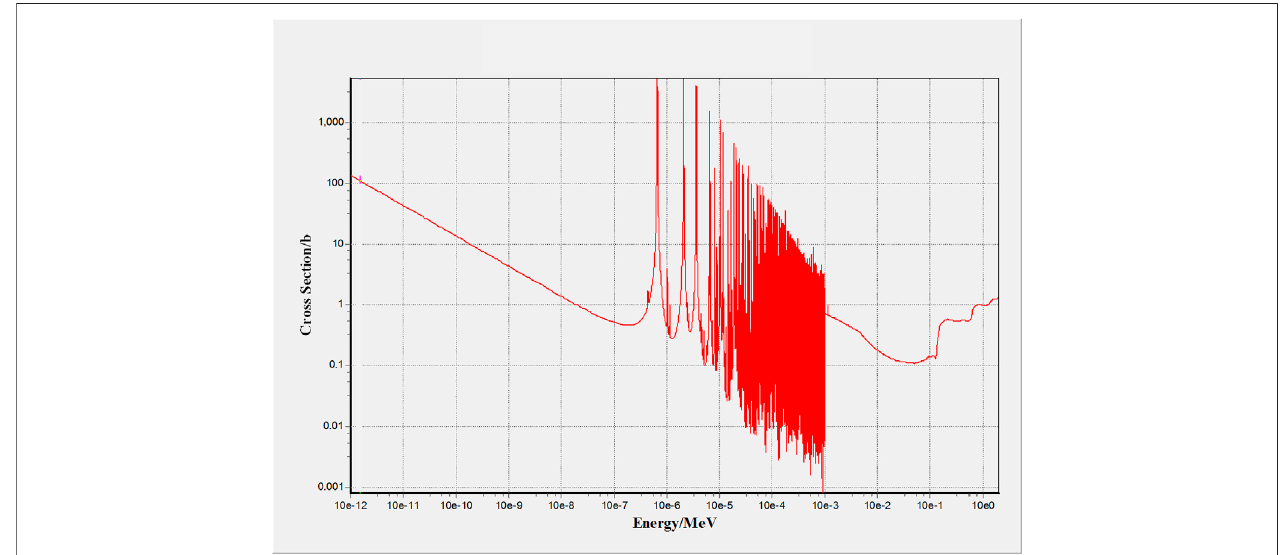
FIGURE 7 | 238 U resonance absorption cross section (600 K).